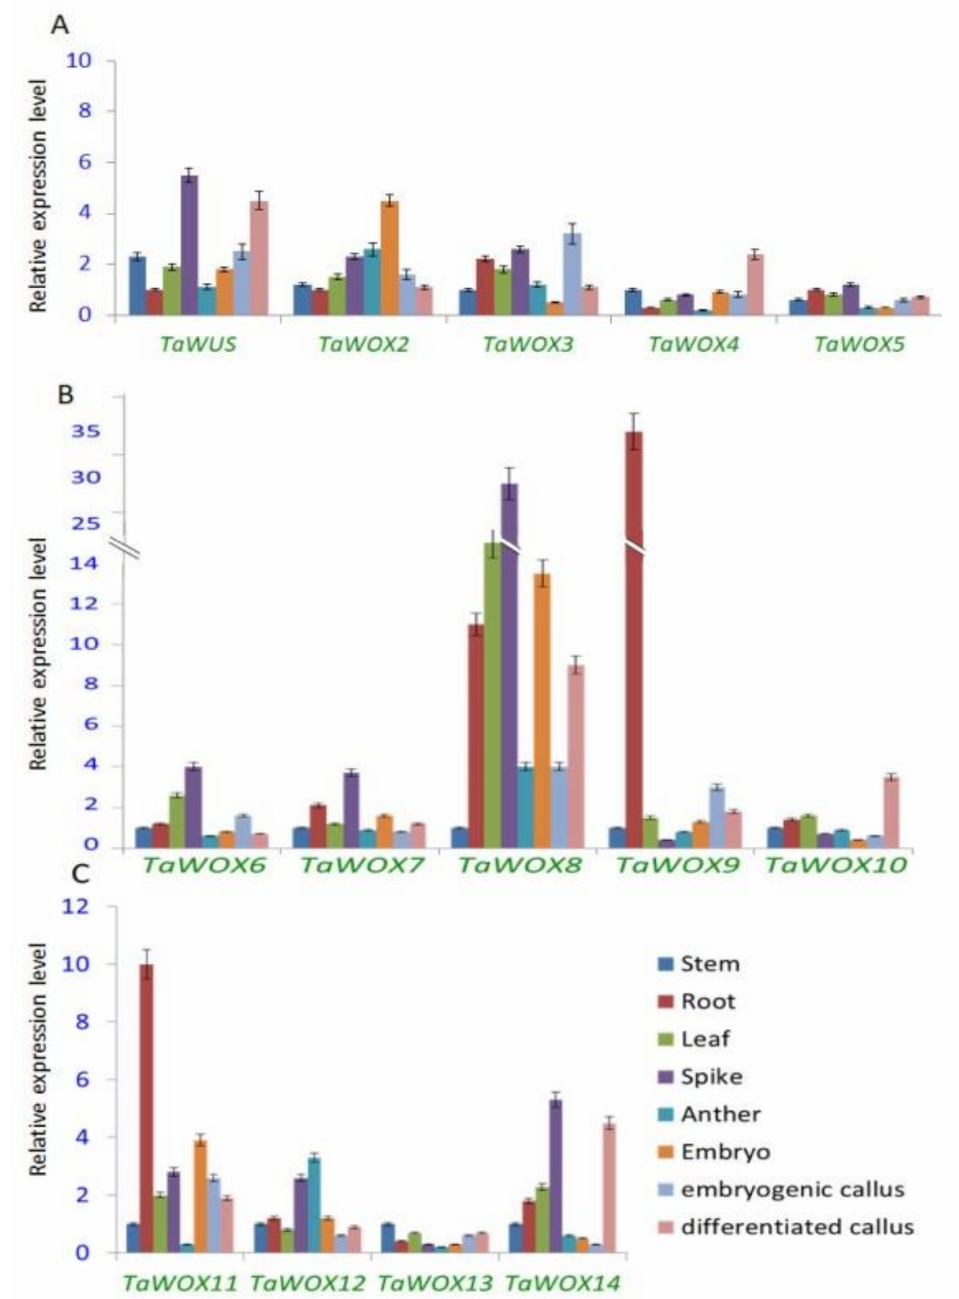
Figure 8. Expression pattern of TaWOX genes in various tissues of T. aestivum . Gene expression level was examined using qPCR. The qPCR data was normalized using wheat TaActin gene. Values were means ± sd of three biological replicates. Expression pattern of TaWUS , TaWOX2 - TaWOX5 ( A ); expression pattern of TaWOX6 - TaWOX10 ( B ); TaWOX11 - TaWOX14 ( C ) were